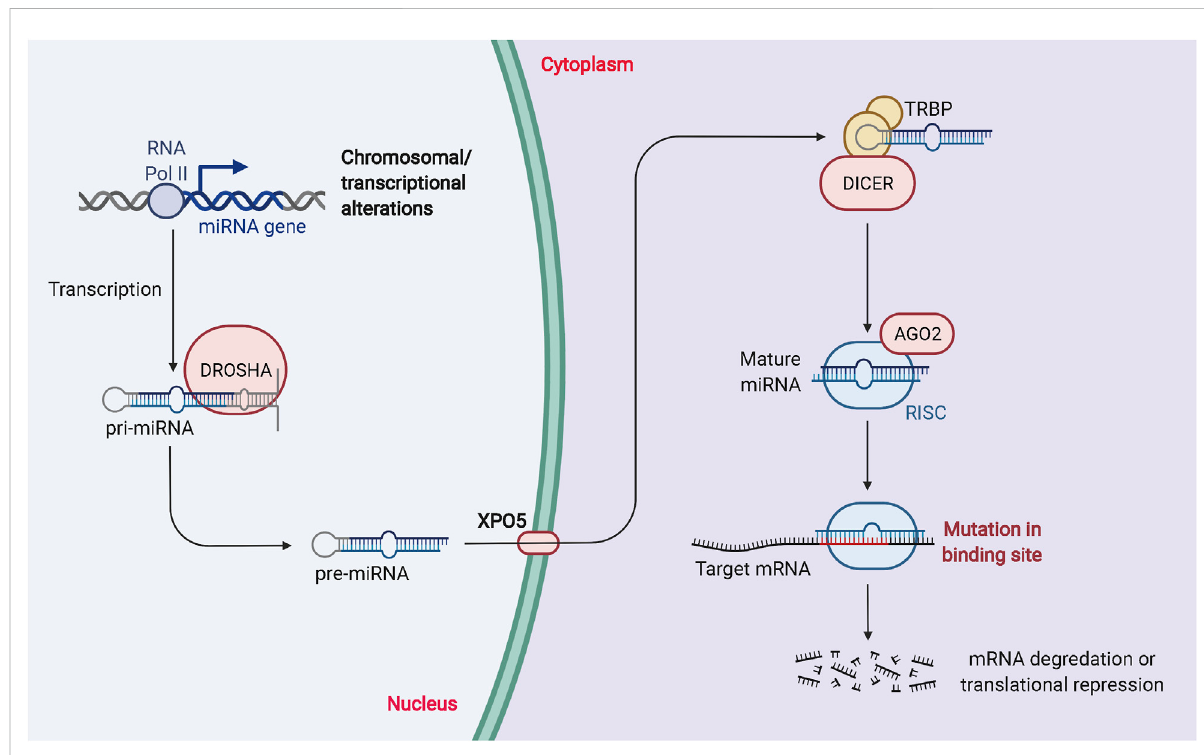
FIGURE 2 The biogenesis and biological function of miRNAs. RNA Pol II or III can regulate the transcription of pri-miRNAs, and DROSHA and DGCR8 can processthenuclearprocessingofpri-miRNAsinto pre-miRNAs.Exportin 5isinvolvedintheprocessing ofpre-miRNAs fornuclearexport.Dicerand TRBP modulation regulatethecytoplasmicprocessing ofpre-miRNAsinto mature miRNA duplexes. miRNA duplexes include passengerstrands and mature miRNAs. The passenger strand is degraded, and the mature miRNA strand is integrated into RISC to mediate translational repression or mRNA degradation depending on the degree of complementarity to the mRNA